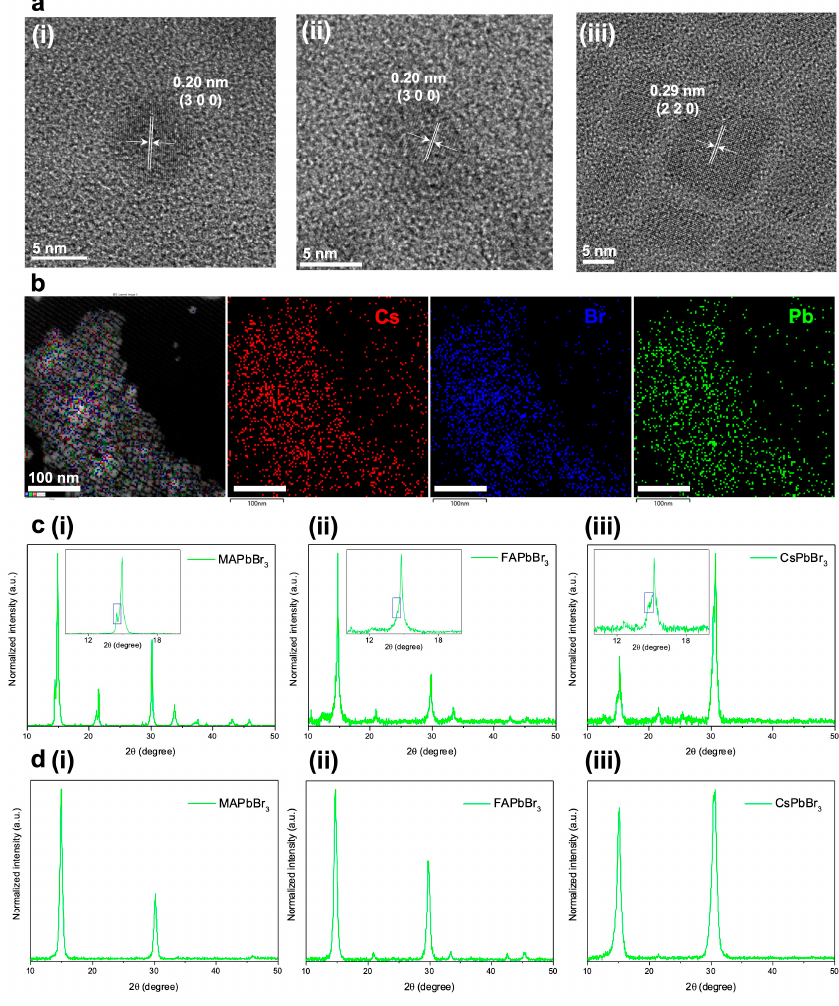
Figure 2. ( a ) HRTEM images of ( i ) MAPbBr 3 , ( ii ) FAPbBr 3 , and ( iii ) CsPbBr 3 NCs, respectively. ( b ) EDS scan of CsPbBr 3 NCs. ( c ) XRD patterns of SSs of ( i ) MAPbBr 3 , ( ii ) FAPbBr 3 , and ( iii ) CsPbBr 3 , with insets emphasizing satellite peaks resulting from reflection splitting due to SS formation. ( d ) XRD patterns of NCs of ( i ) MAPbBr 3 , ( ii ) FAPbBr 3 , and ( iii ) CsPbBr 3